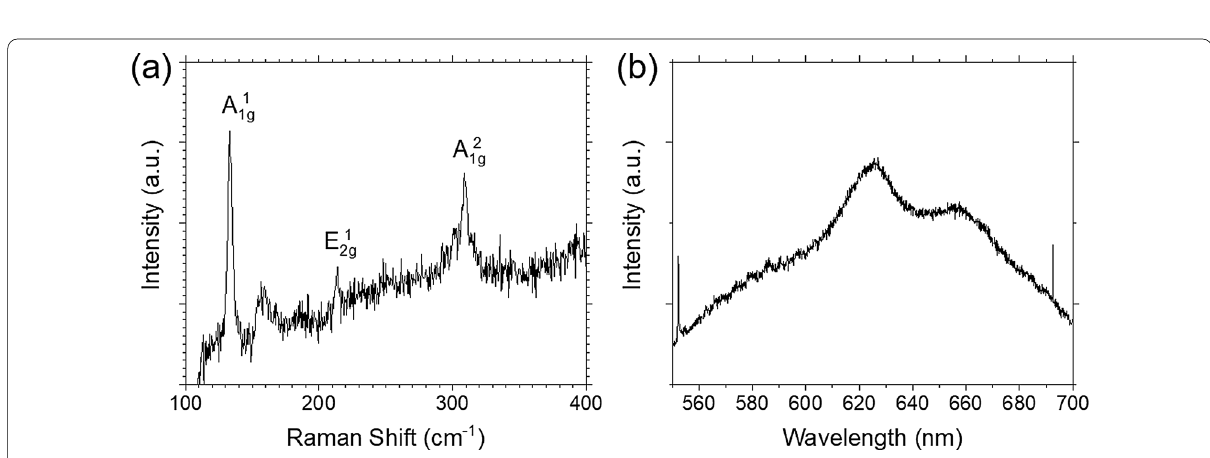
Fig. 3 a Raman and b PL spectra of GaSe